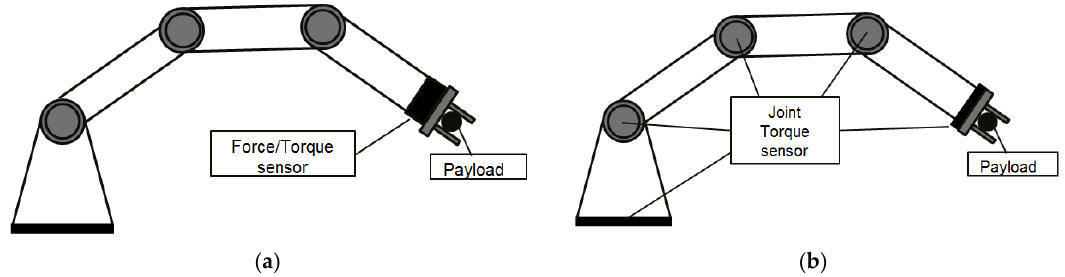
Figure 1. Force and torque sensors for manipulator. ( a ) 6-axis FT(force/torque) sensors; ( b ) joint torque sensors.